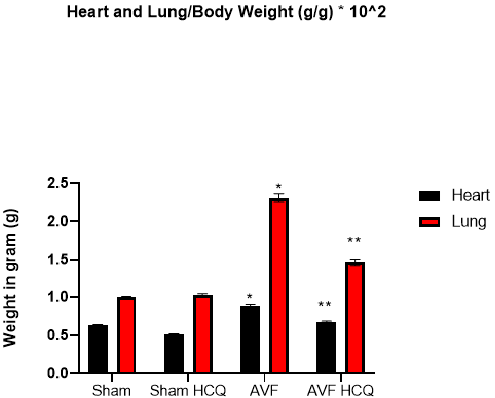
Figure 1. Heart and lung weights of AVF and sham mice treated with and without the HCQ. The weights were normalized with weight of the tissue. *, <0.05 compared with sham, **, <0.05 compared with AVF; n = 5–8 in each group.